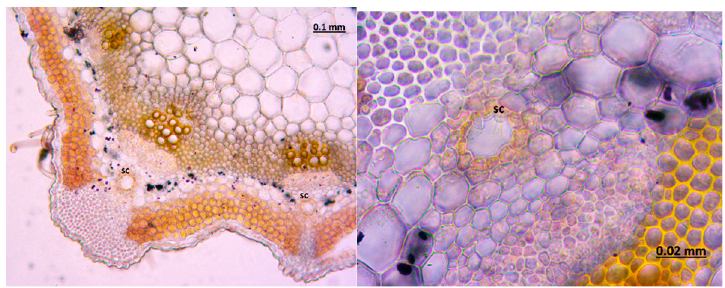
Figure 6. Secretory canals at the ray of Zosima absinthifolia by light microscopy.